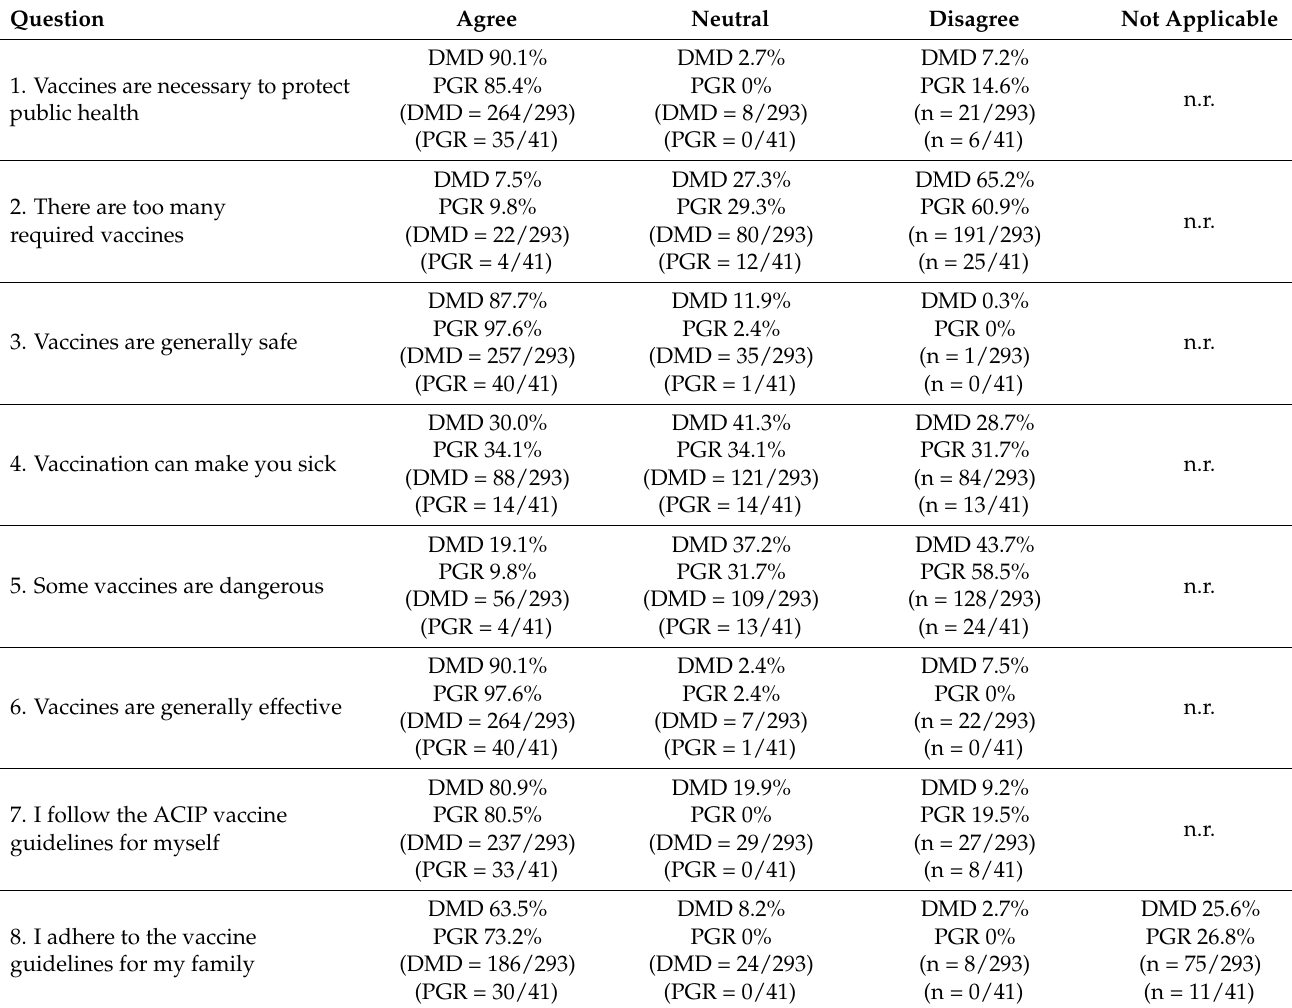
Table 2. General vaccine related survey responses of DMD students and